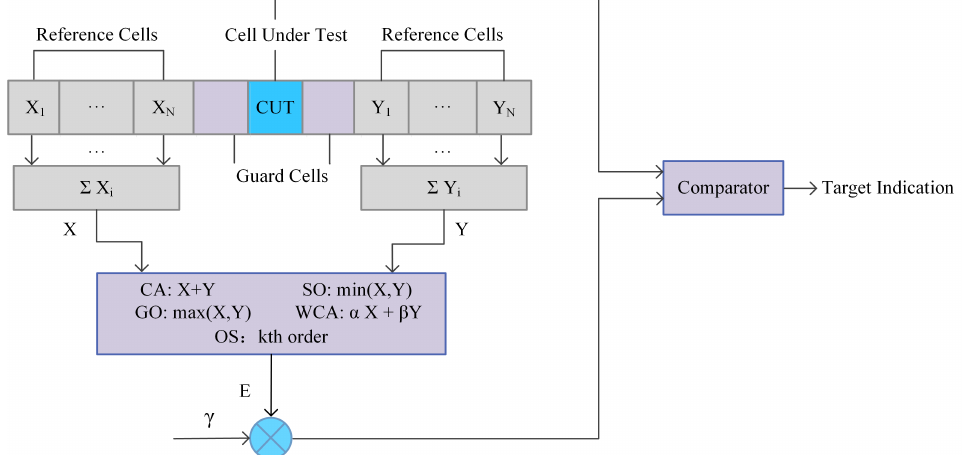
Figure 3. Common CFAR